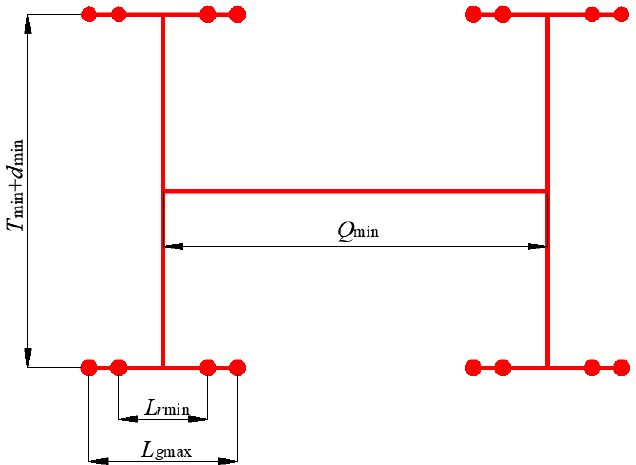
Figure 8. Most adverse bogie model.